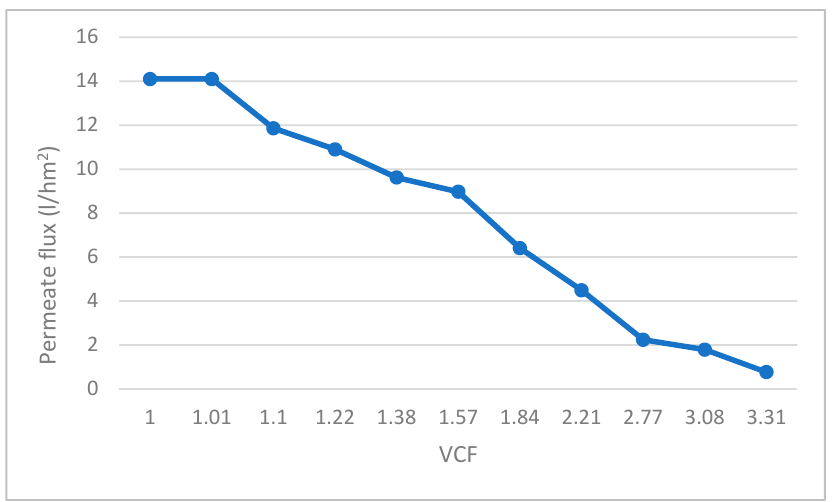
Figure 6. Permeate flux vs. VCF over the duration of the reverse osmosis filtration pilot test.